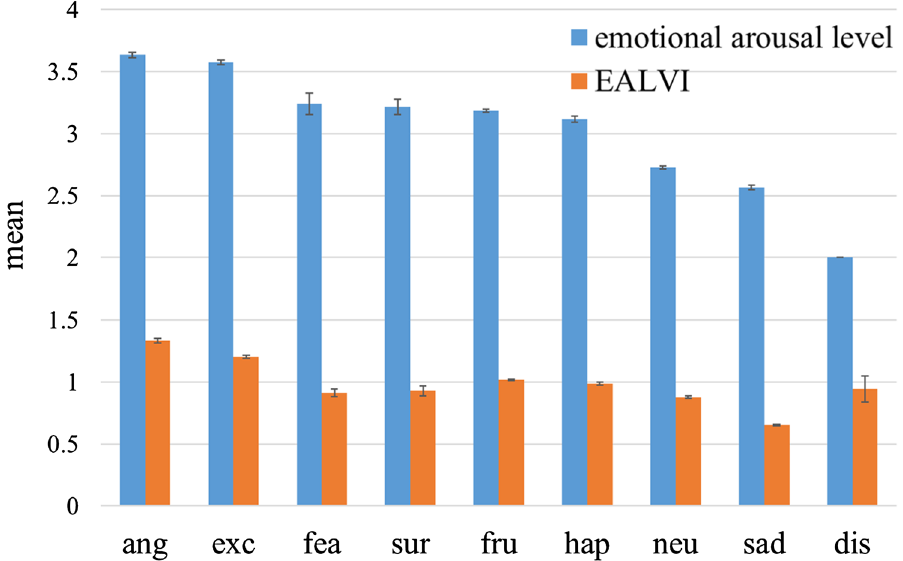
Figure 3. The mean emotional arousal level and mean EALVI value for each emotion category. Note : Error bars represent standard error. Additionally, ang = angry; exc = excited; fea = fearful; sur = surprised; fru = frustrated; hap = happy; neu = neutral; sad = sad; dis = disgusted.